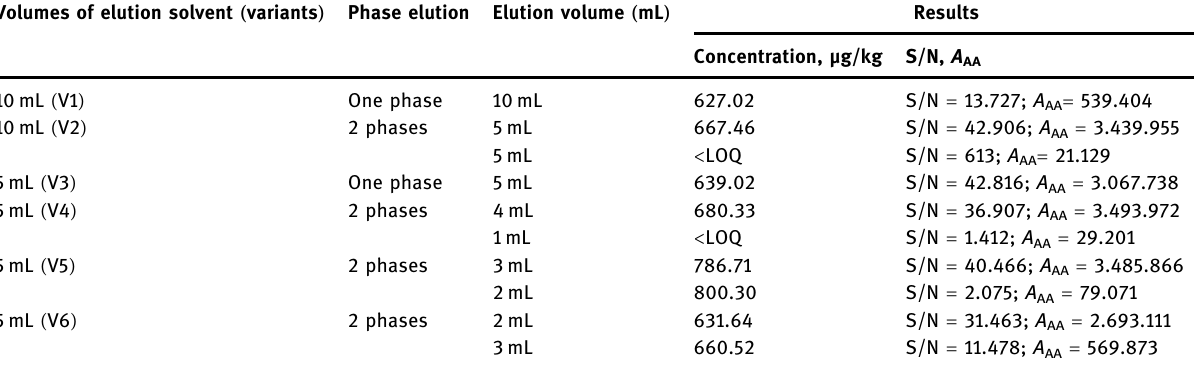
Table 2: AA content of RM ( potato crisps, 625 ± 45 µg/kg ) obtained by using di ff erent volumes of elution solvent Volumes of elution solvent ( variants ) Phase elution Elution volume ( mL )